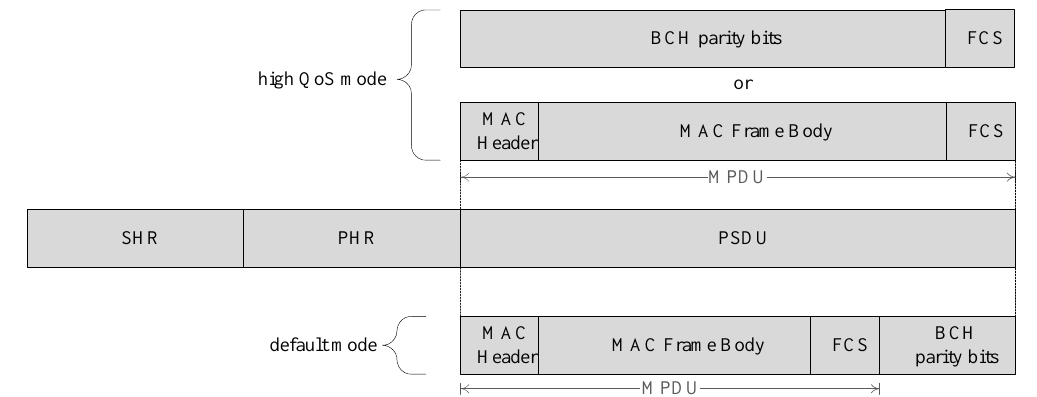
Figure 4. PPDU frame structure for UWB